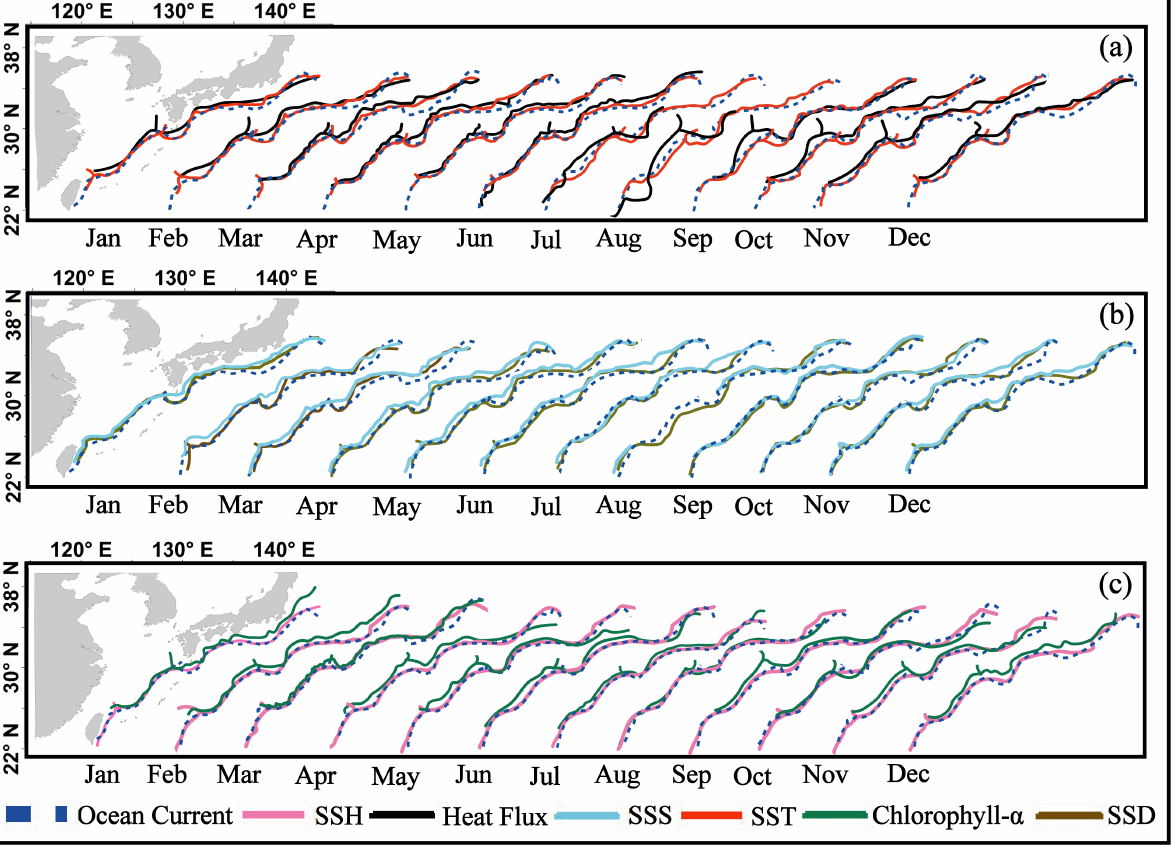
Figure 9. The KC centerline from monthly climatology ( a ) Sea Surface current (dotted blue) overlaid on SST (red) and Heat Flux (black); ( b ) comparison of Sea Surface current (dotted blue) with SSS (cyan) and SSD (brown); ( c ) Sea Surface current (dotted blue) with chlorophyll- α (green) and SSH